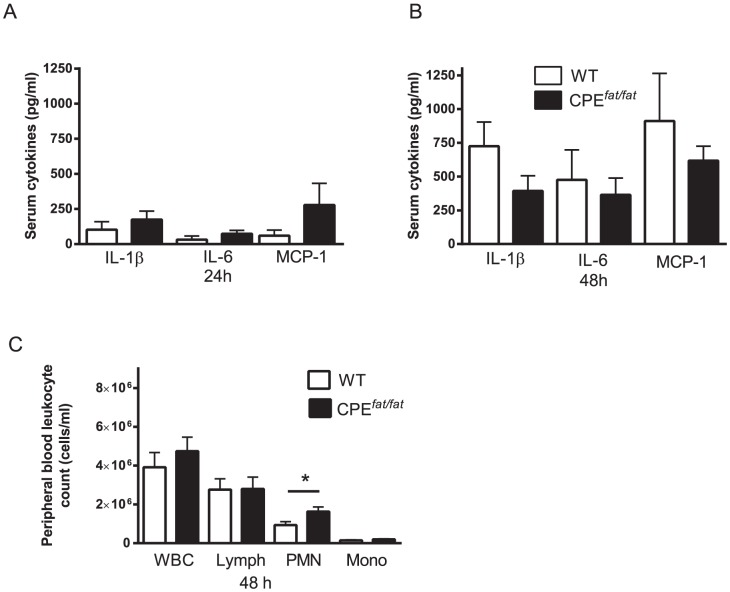
Serum cytokines (A and B) and peripheral blood cell counts (C) in WT and CPEfat/fat mice following S. pneumoniae challenge.WT and CPEfat/fat mice were challenged with 105 CFUs of S. pneumoniae via the intratracheal route and serum was prepared from blood samples obtained 24 and 48 h post-infection as mentioned in the 
Materials and Methods
 section. n = 5–7 mice per group *, p<0.05 vs WT using a student's t-test.